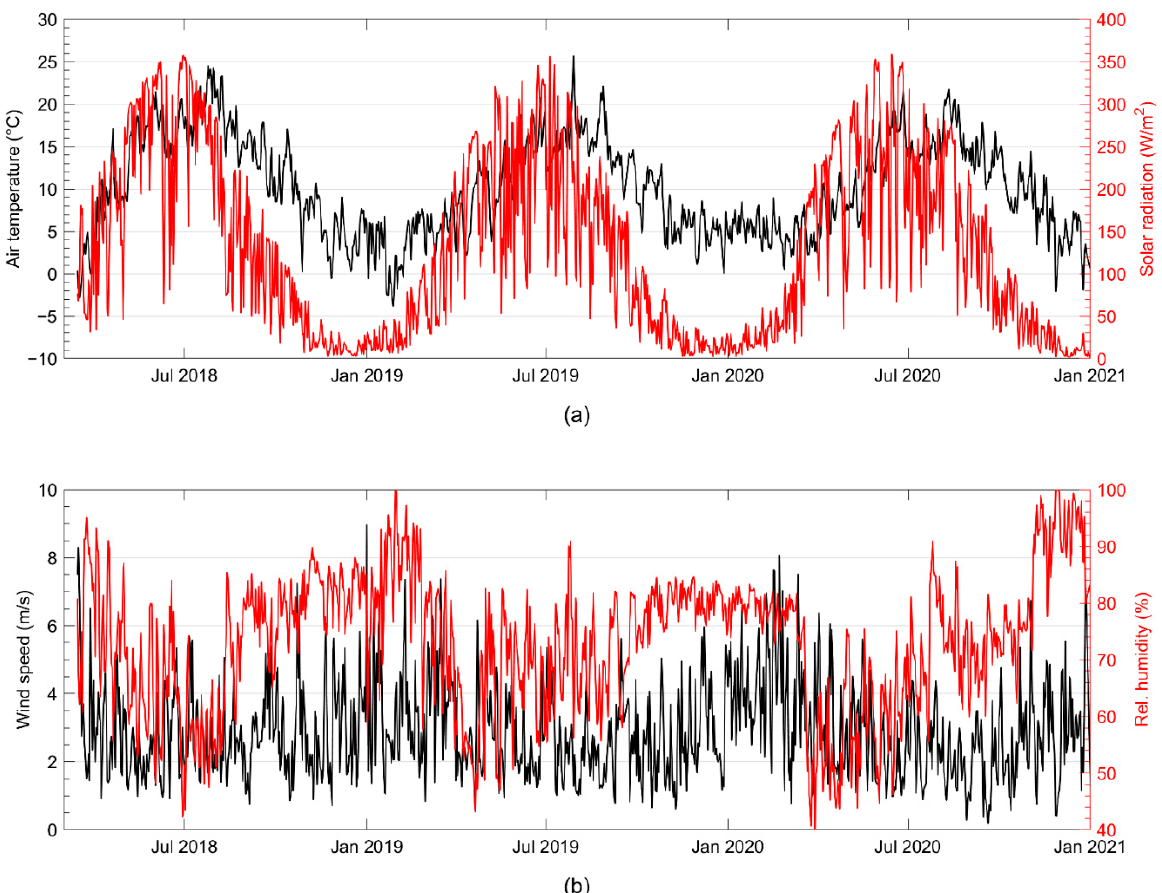
Figure 8. ( a ) Measured daily average air temperature and solar radiation at the Climate Road. ( b ) Wind speed and relative humidity at the Climate Road. Measured precipitation was compared to corresponding measured monthly Darcy flow rates, estimated by normalizing measured discharge volumes by the 400 m 2 of road surface (Figure 9).